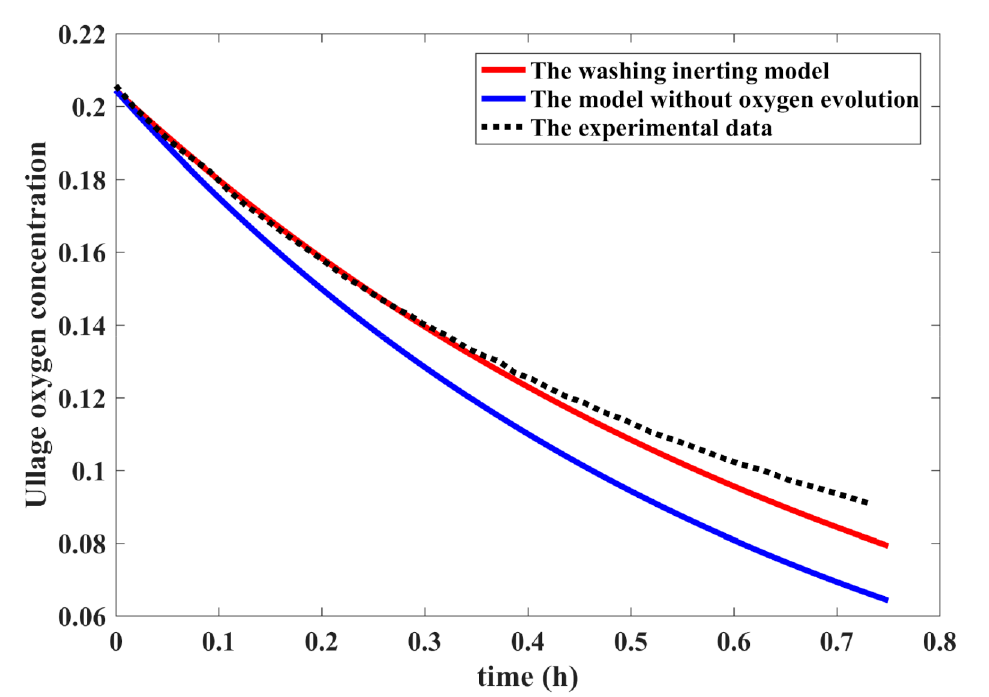
Figure 3. Experimental and calculated results of z Uov in the pre-takeoff phase, with a fuel load of 50% and a NEA mass flow rate of 0.9